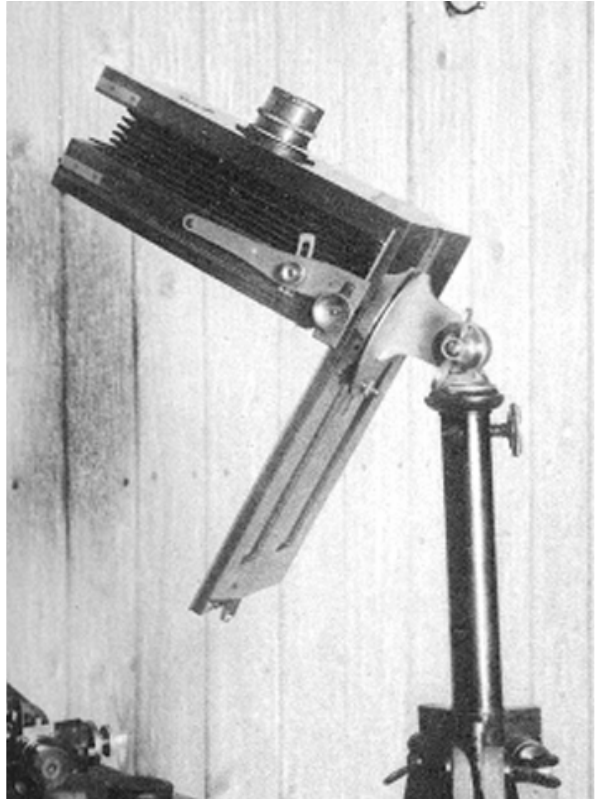
Fig. 4. Auroral photocamera of the Russian expedition to Spitsber- Figure 4. Auroral photocamera of the Russian expedition to Spitsbergen.